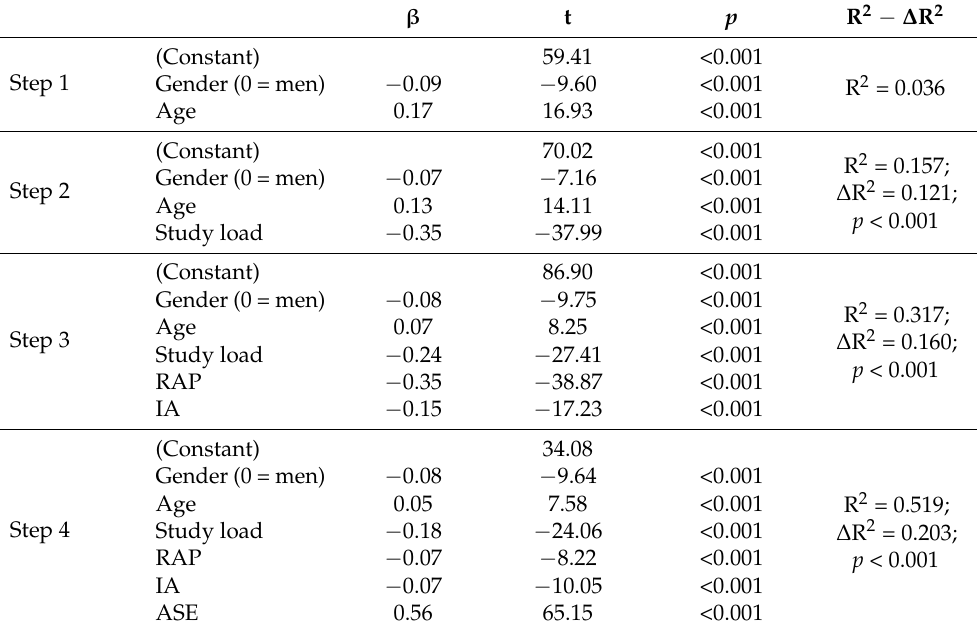
Table 7. Hierarchical multiple regression with engagement as dependent variable (N =